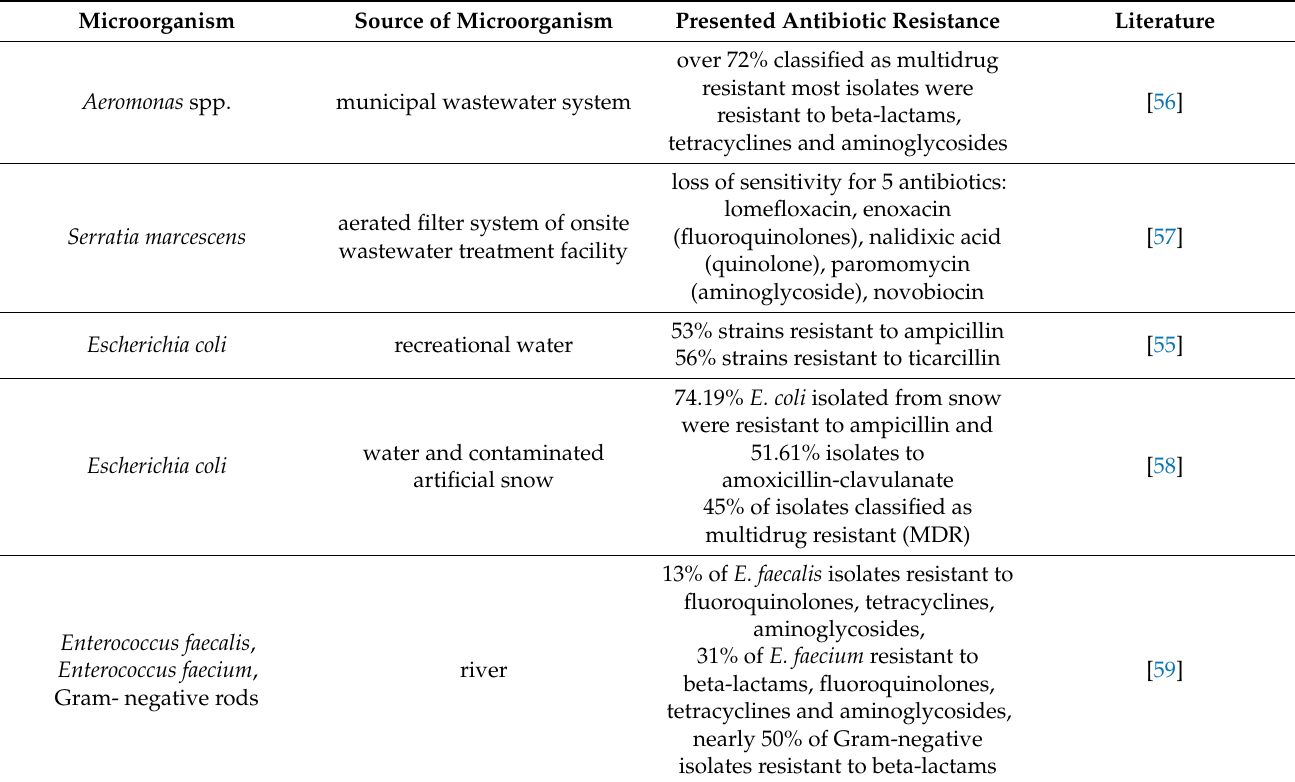
Table 4. Microorganisms spread directly or indirectly by